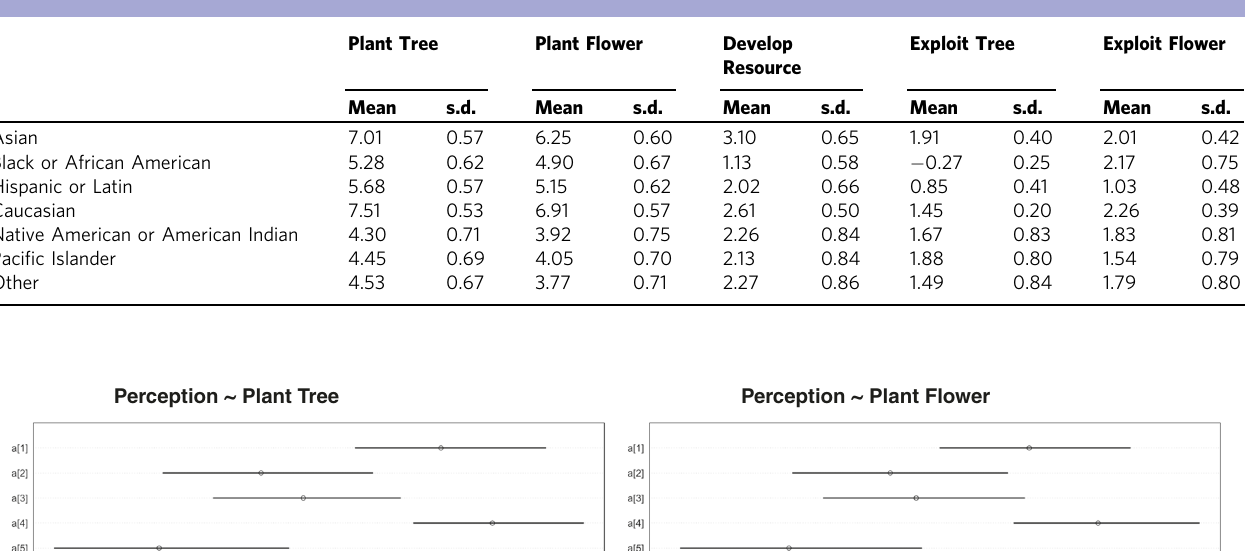
Table 6 The posterior distributions of the models.